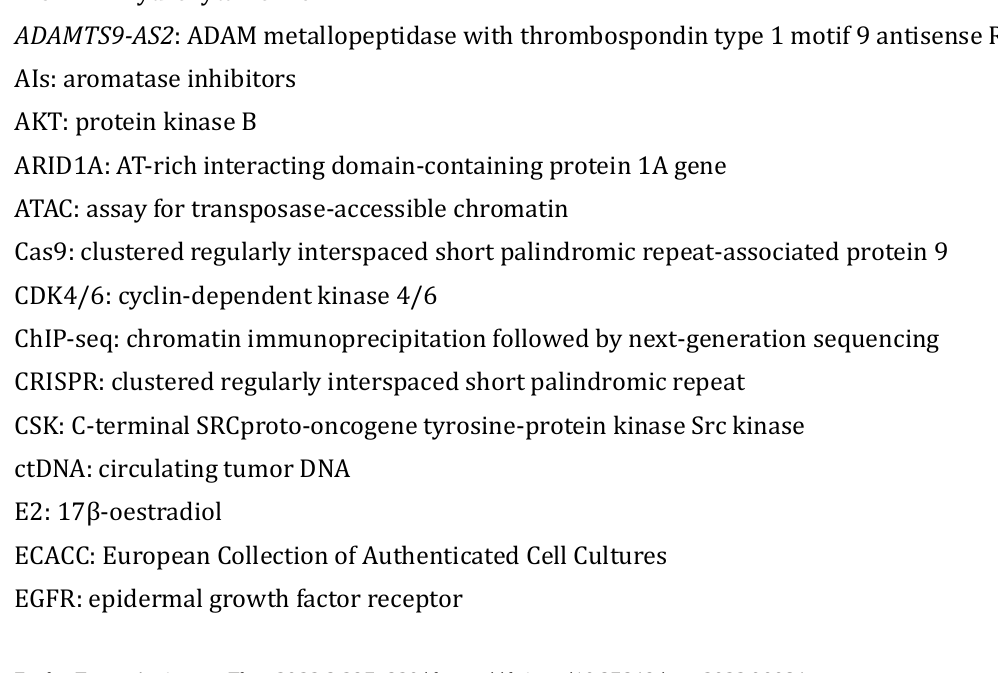
CRISPR: clustered regularly interspaced short palindromic